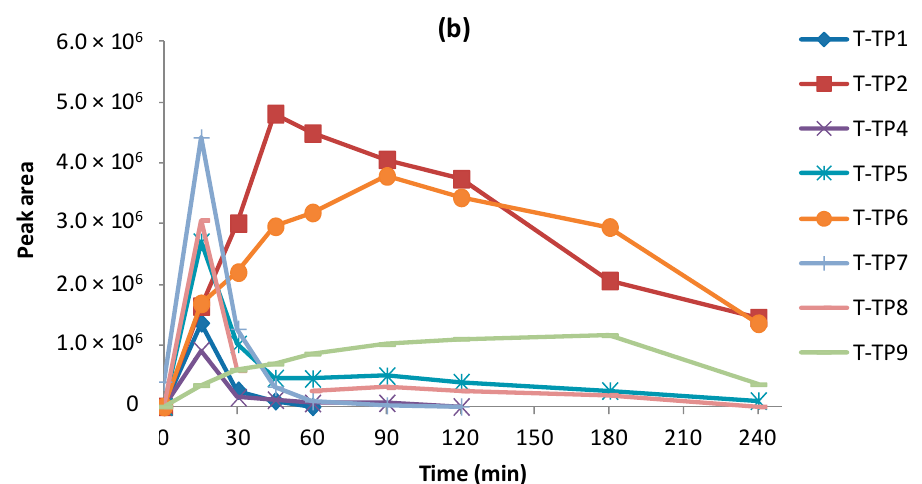
Figure 6. Evolution profiles of major ( a ) and minor ( b ) VLS TPs by TiO 2 photocatalytic oxidation process.